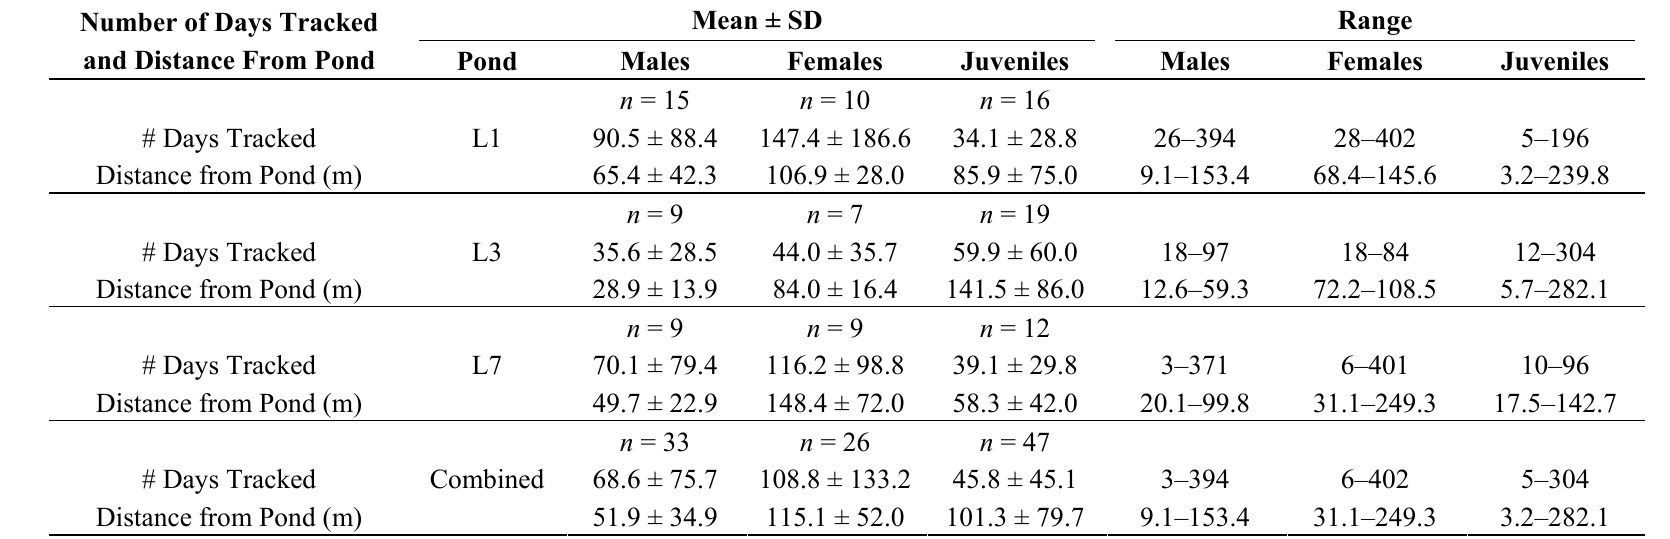
Table 1. Summary the number of days tracked and maximum distance from the breeding pond of 59 adult and 47 metamorphic tiger salamanders at Brookhaven National Laboratory, Long Island, New York, USA from